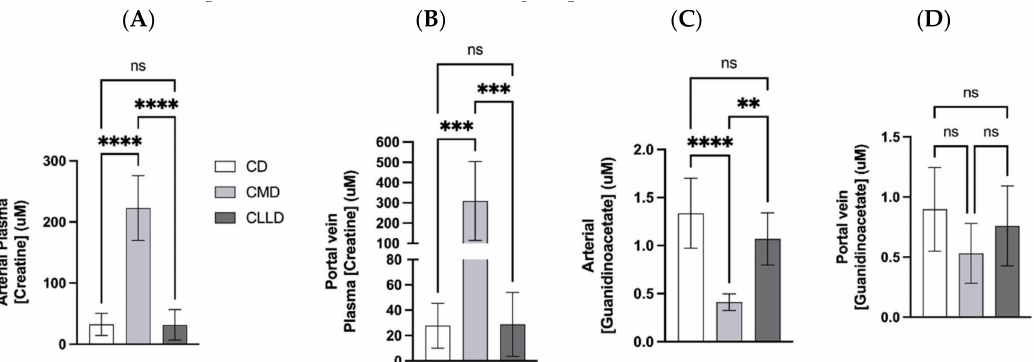
Figure 4. Plasma concentrations of creatine and guanidinoacetate. Panel ( A ) arterial plasma concen- tration of creatine; panel ( B ) portal venous plasma concentration of creatine; panel ( C ) arterial plasma concentration of guanidinoacetate; panel ( D ) portal venous concentration of guanidinoacetate. The open bar represents rats fed creatine-free diet (CON), light gray bar represents rats fed 0.4% w / w cre- atine monohydrate supplemented diet, dark gray bar represents rats fed 0.656% CLL supplemented diet. Values are presented as the mean ± one standard deviation, n = 8 per group. Asterisks indicate significance by p -value; p < 0.0001 = ****, p < 0.001 = ***, p < 0.01 = **, ns = not significant.